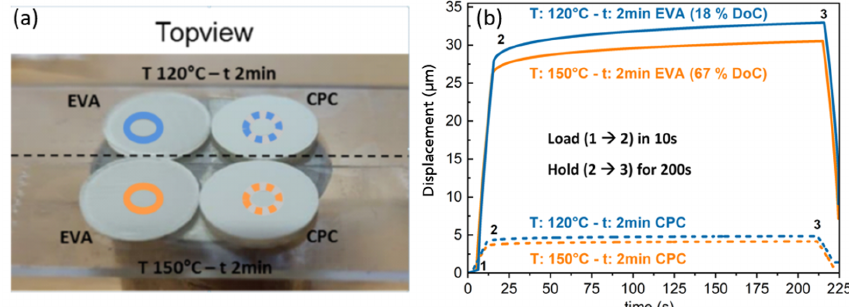
Figure 11. ( a ) Image of mounted samples with exposed surfaces of interest (EVA with linear circles and backsheet (CPC) with dashed circles) for nanoindentation tests. ( b ) Creep data on the same surfaces with 40 mN maximum load 40, 200 s duration of creep.